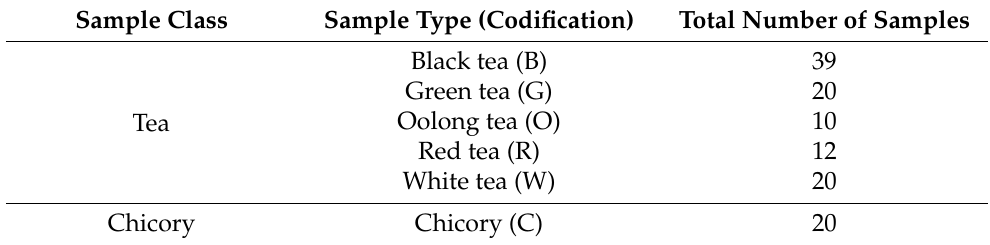
Table 1. Number and varieties of the analyzed tea and chicory samples.